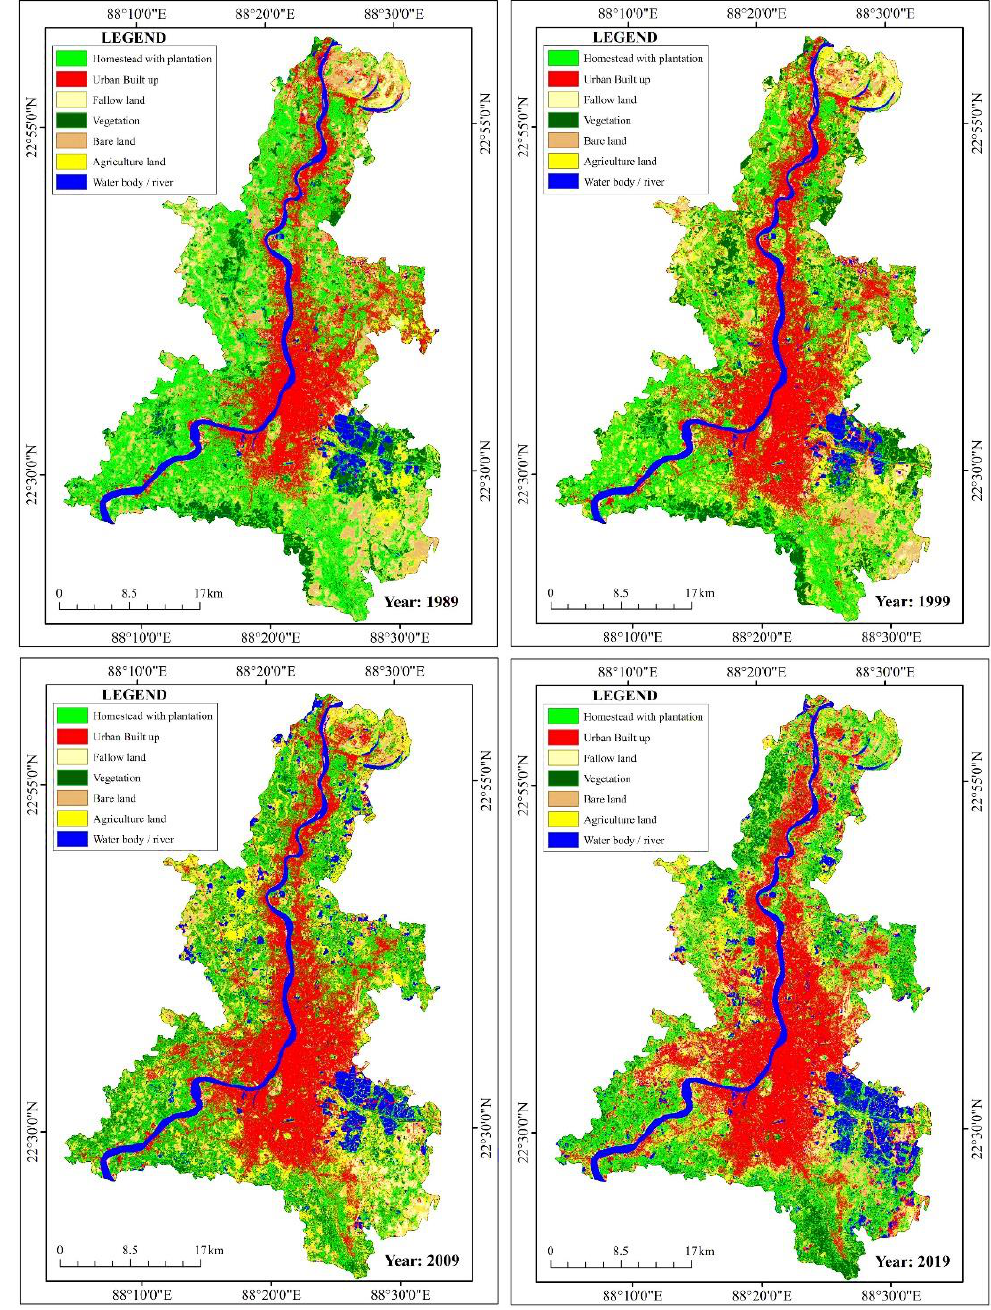
Figure 2. Land use and Land cover map corresponding to the study area for the years 1989, 1999, 2009, and 2019.